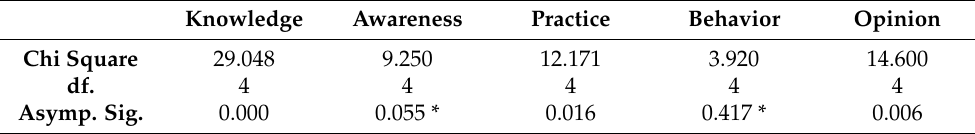
Table 8. Test statistics of Kruskal–Wallis H test of five variables for laboratory